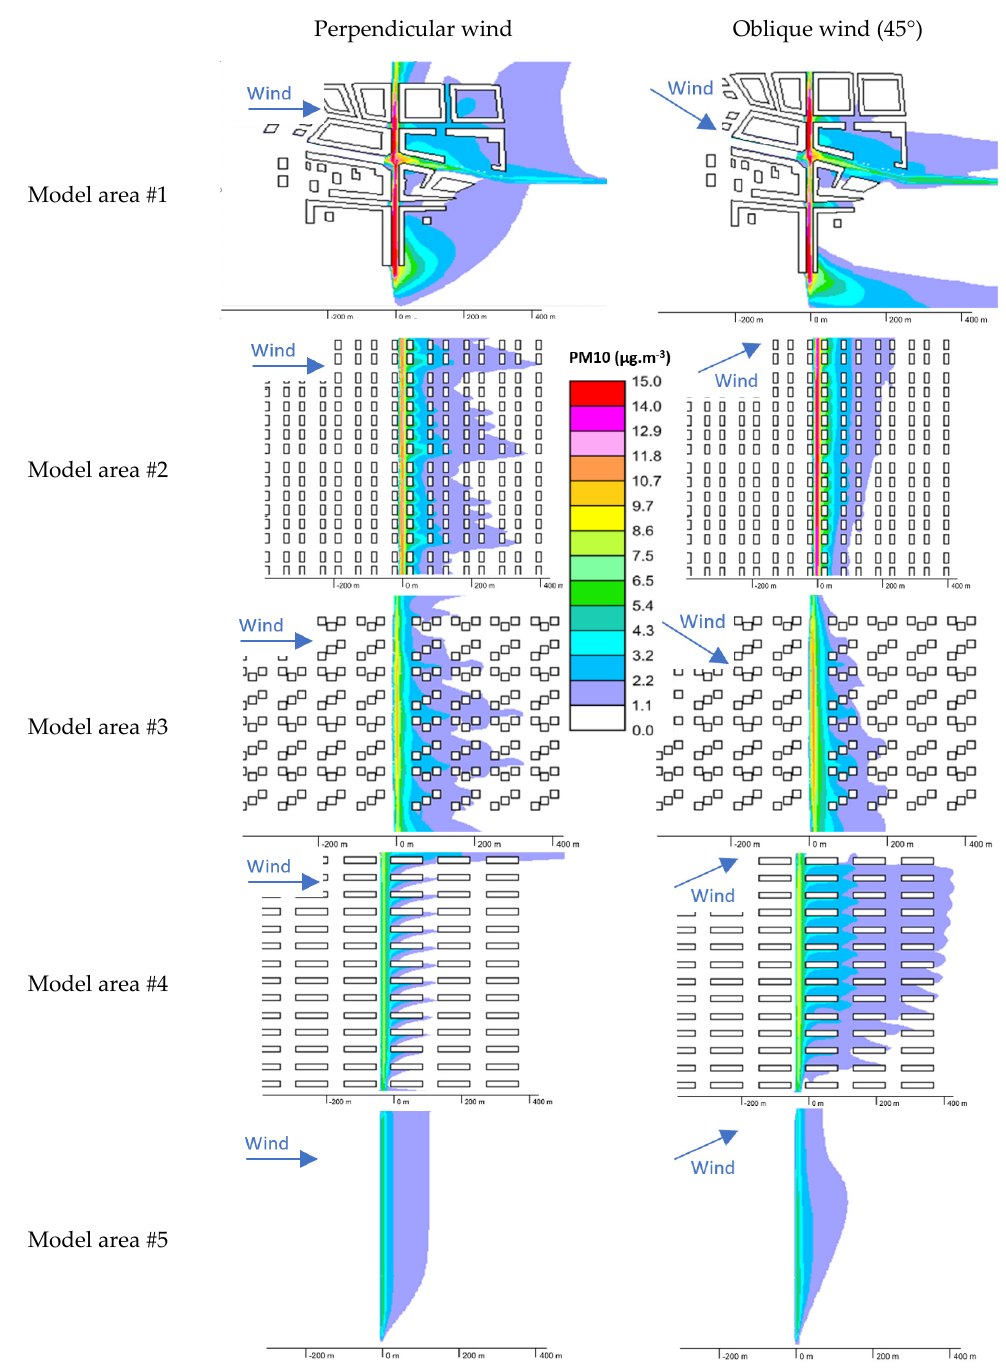
Figure 4. The PM10 mass concentration fields related to the height of 1.5 m above the ground for the wind velocity 2m·s − 1 perpendicular and oblique wind directions.